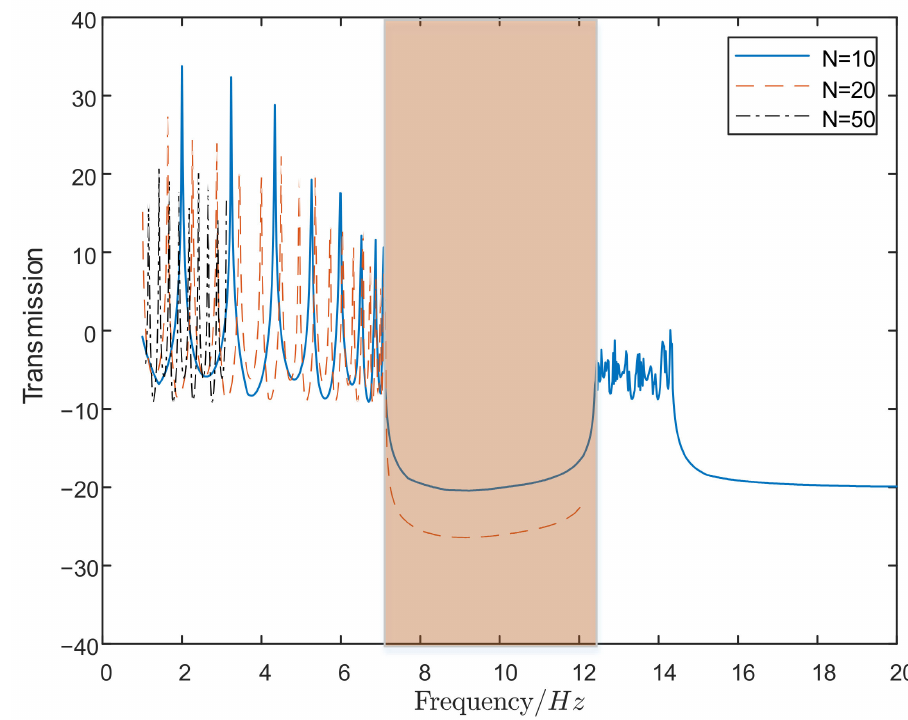
Figure 13. Influence of unit cell number on band gap ( U = 0.1; γ =